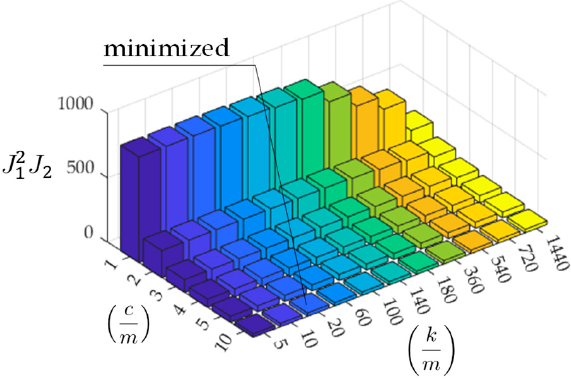
J 2 . Figure 17. The product of objective functions: J = J 2 1 (cid:0) c (cid:1) ) = 20, the estimated road unevenness functions, R ( x ) , as When = 10 and ( k m m Figure 17. The product of objective functions: 𝐽 = 𝐽 (cid:2869)(cid:2870) 𝐽 (cid:2870) . shown in Figure 18a, are similar to each other. From this result, there is a probability that the accuracy of the vehicle parameters may not affect the estimation accuracy of the road .. R ( x ) , and the reproduced road roughness. The estimated road unevenness accelerations, .. r , are shown in Figure 18b,c, respectively. The estimated unevenness acceleration, AA + (cid:0) c (cid:1) ) = 20 are also road unevenness angle, R (cid:48) ( x ) , and curvature, R (cid:48)(cid:48) ( x ) , when = 10 and ( k m m .. R ( x ) have been erased. shown in Figure 19. Many of the extremely large values included in However, the reproducing accuracy is not high because the parameters are not